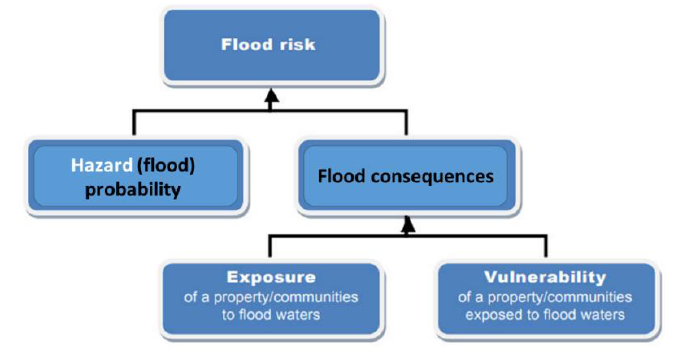
Figure 1. Components of flood risk (Modified from The State of Queensland, 2011)